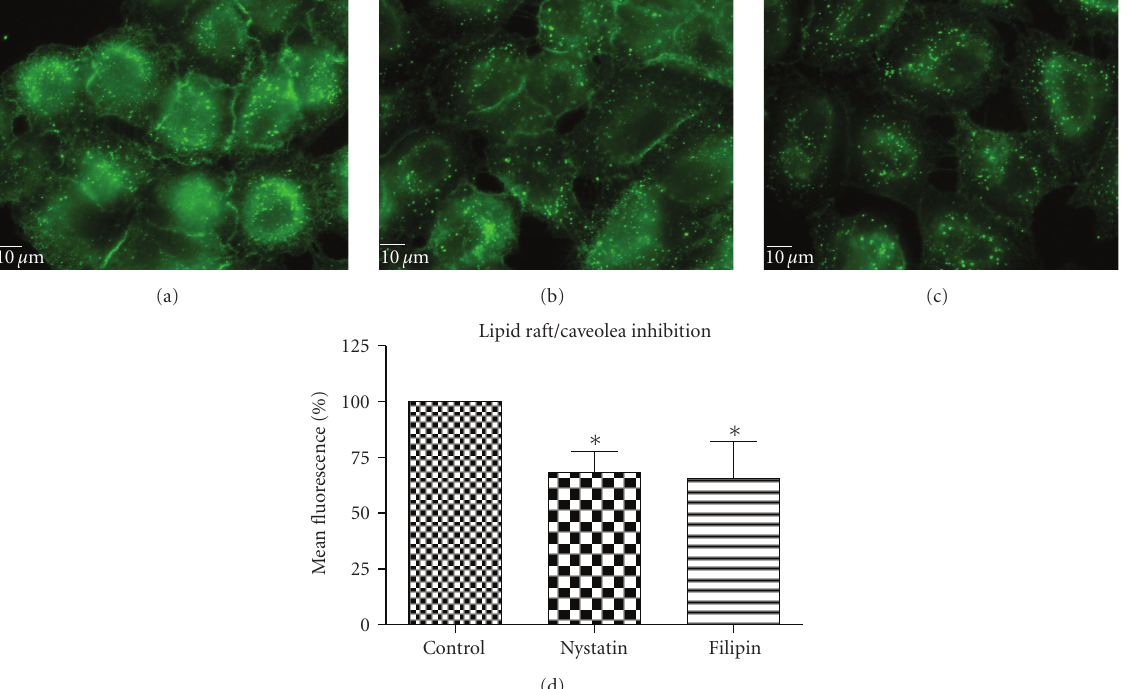
Figure 8: Lipid raft/caveolin inhibition decreased QD/SR9 internalization (150 nM; 1:20; 1 hour). (a) Control cells. (b) Cells pretreated with nystatin for 30min then incubated with QD/SR9 for an additional 1 hour. (c) Cells pretreated with filipin for 30min then incubated with QD/SR9 for an additional 1 hour. Images are from a single plane of Z series. (d) Fluorescence intensity. Values are mean ± SD from three independent experiments ( ∗ P (cid:5) s < . 01 versus